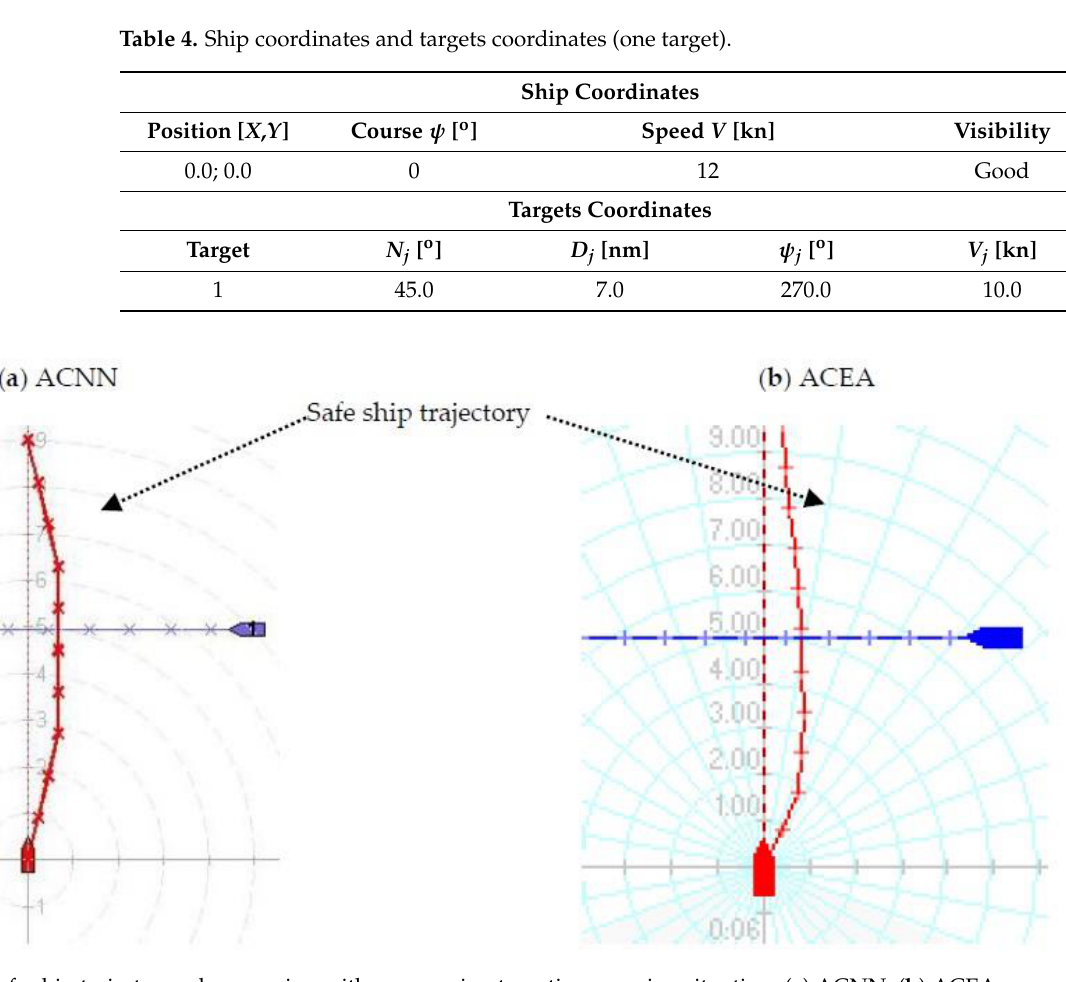
Figure 7. Safe ship trajectory when passing with one moving targetin a crossing situation. ( a ) ACNN; ( b ) ACEA.